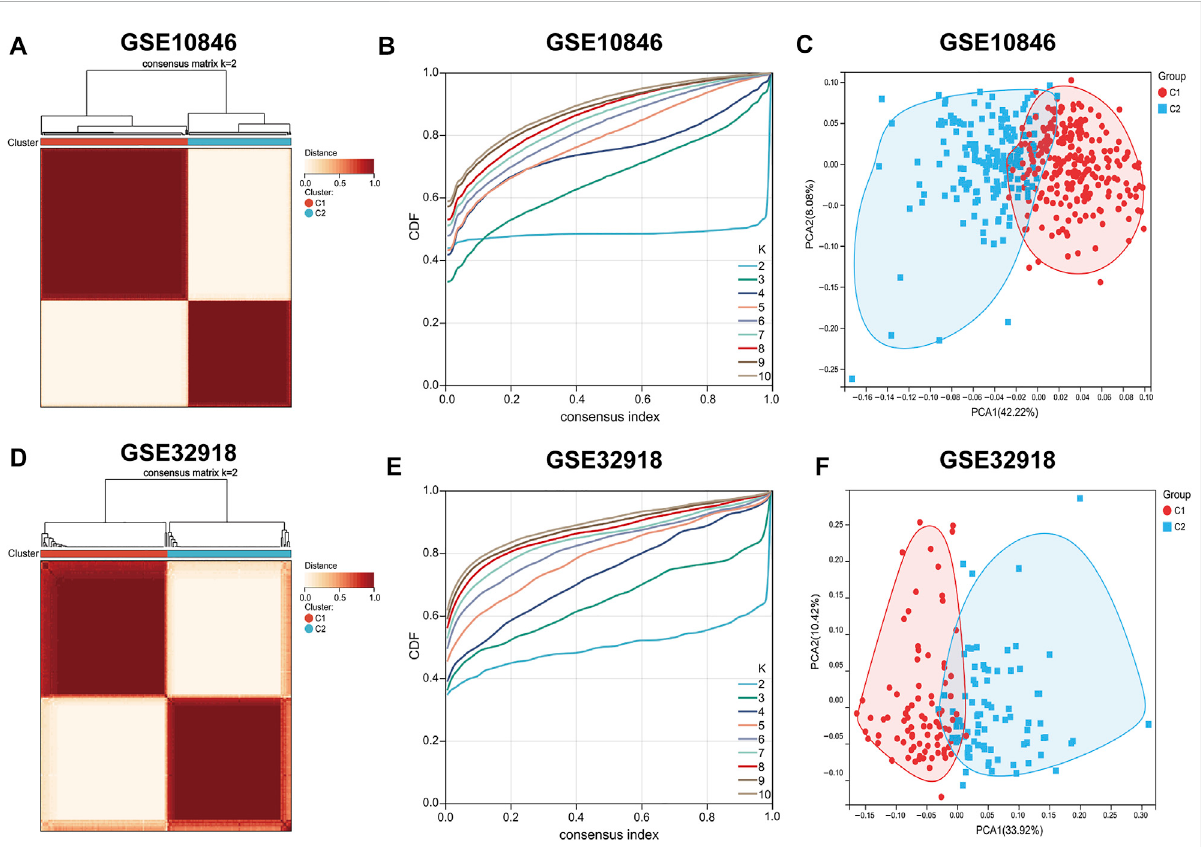
FIGURE 1 Consensus clustering of DLBCL patients. (A – D) Consensus matrix heatmaps indicating that the optimal value for consensus clustering is K = 2both in thetraining and validation sets. (B,E) Cumulativedistributionfunction (CDF) ( K = 2 – 10). (C – F) Principalcomponentanalysis(PCA) based on ssGSEA scores of the training and validation sets. Each point represents a sample, and different colors distinguish immune